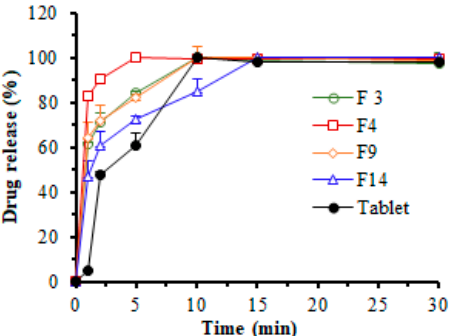
Figure 12. In vitro release pattern of RZT-ODFs and commercial tablets in simulated salivary fluid at pH 6.8. The various colored lines represent different formulations: green (F3; PUL = 300), dark red (F4; PUL:MTX = 300:100), orange (F9; PUL:MTX = 400:100), blue (F14; PUL:MTX = 500:100), and black color (commercial tablets). All RZT-ODFs were treated with the same amount of plasticizer (25%). Results are presented as a mean ± SD of triplicates.